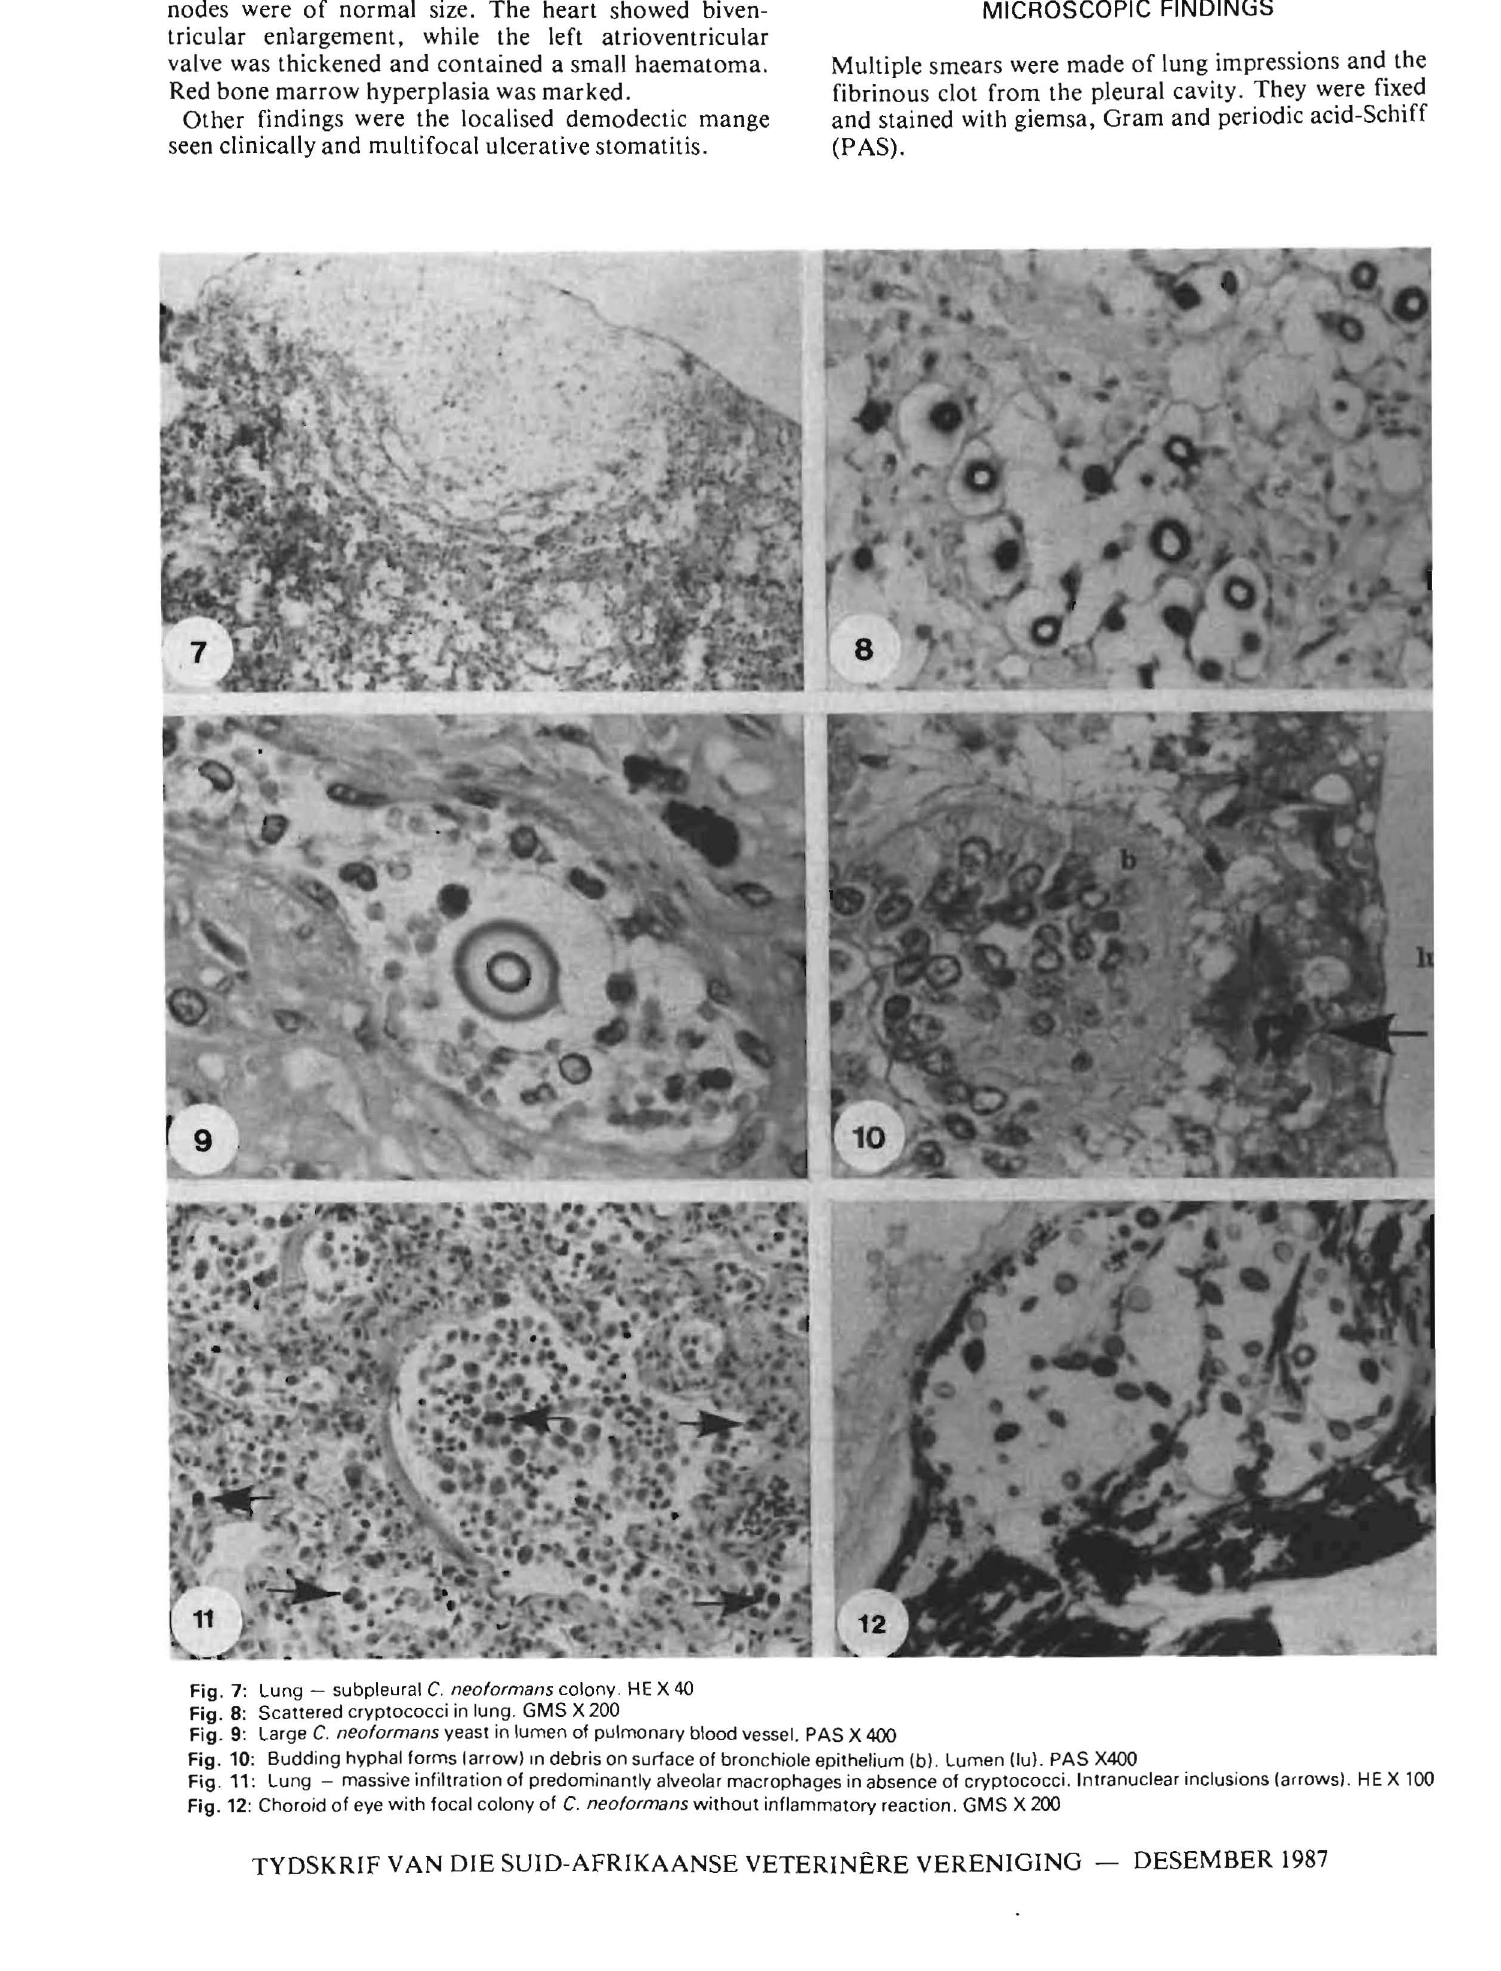
Fig. 7: Lung - subpleural C. neoformans colony. HE X 40 Fig. 8: Scattered cryptococci in lung. GMS X 200 Fig. 9: Large C. neoformans yeast in lumen of pulmonary blood vessel. PAS X 400 Fig. 10: Budding hyphal forms farrow) In debris on surlace of bronchiole epithelium (bL Lumen (luL PAS X400 Fig. 11: Lung - massive infiltration of predominantly alveolar macrophages in absence of cryptococci. Intranuclear inclusions (arrows). HE X 100 Fig. 12: Choroid of eye with focal colony of C. neoformans without inflammatory reaction . GMS X 200 TYDSKRIF VAN DIE SUlD-AFRIKAANSE VETERINERE VERENIGING - DESEMBER